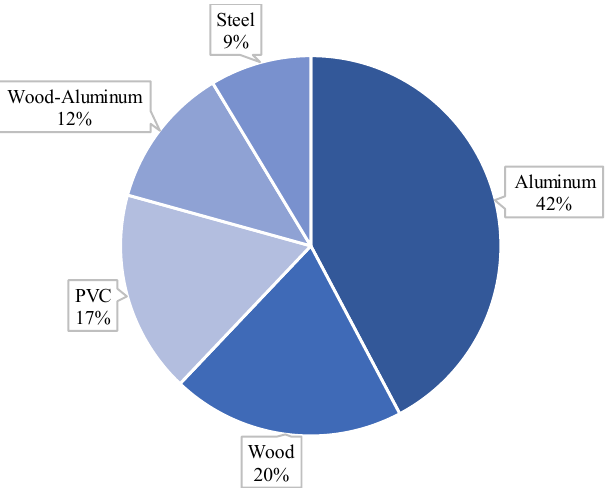
Figure 1. Percentage distribution of the materials of the frame of the sample.